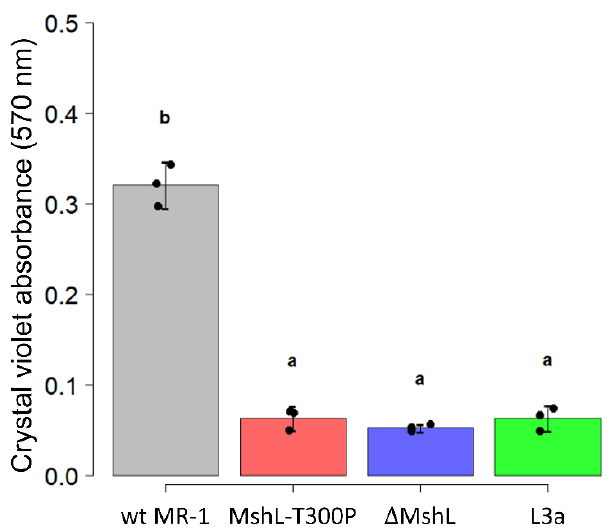
Figure 1. Crystal violet biofilm assay. Biofilm assessments were conducted in LCM. Absorbance at 570 nm corresponds to crystal violet staining intensity. Higher absorbance readings indicate more robust biofilms. Statistical groupings are indicated by letters above each box for a significance threshold of p < 0.05. Letters in common between groups indicate the absence of a significant difference between the groups’ means. MshL-T300P: missense mutation at MshL’s 300th amino acid position, ∆ MshL: MshL deletion mutant, wt MR-1: unpassaged S. oneidensis strain, L3a: evolved isolate containing the MshL-T300P mutation.